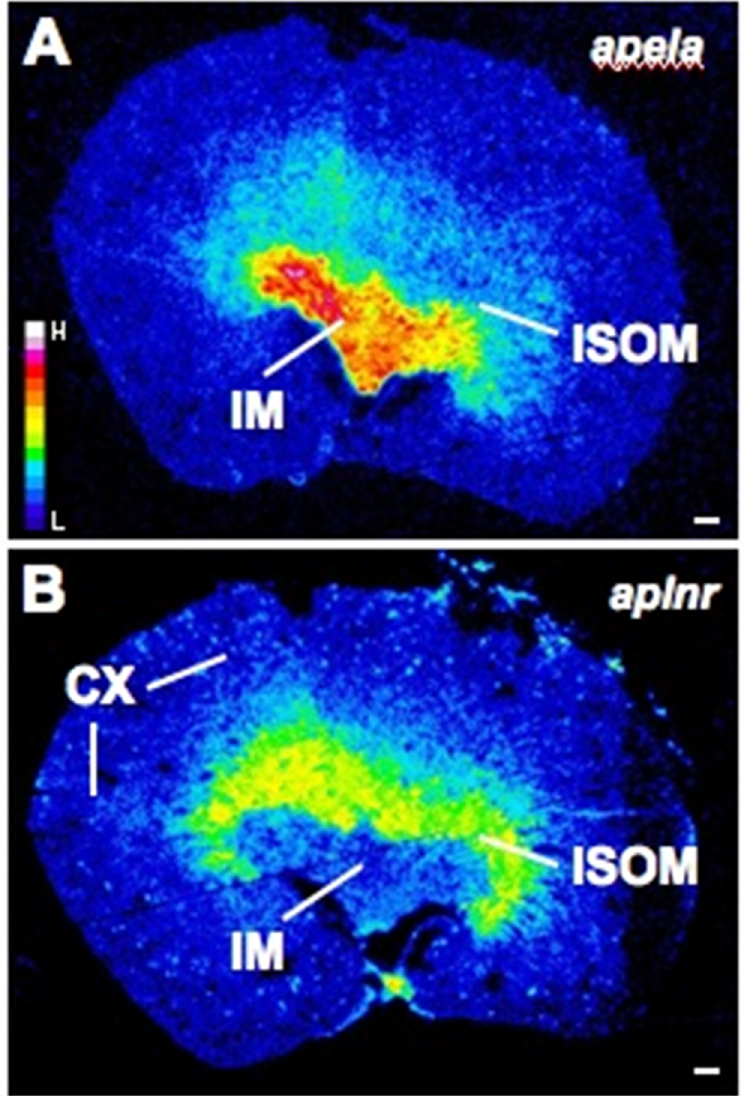
Fig 3. Representative autoradiographic film images demonstrating apela (A) and aplnr (B) expression in serial sections of a kidney from an adult male Wistar rat. Apela is highly expressed in the inner medulla (IM) whereas aplnr labellingis primarily in the inner stripe of the outer medulla(ISOM). In contrast to the apela labelling,the aplnr probesalso label a subpopulation of glomeruli(patchy ‘dots’) in the cortex (CX). The film images were exposed to film for 3 months, developed, scanned,exportedto Image J and pseudocoloured. In these images yellow-reddesignates high expressionwhereasblue-black representsnegligibleor no labelling (see pseudocolour scale bar in ( A )). The images are representative of results obtainedfrom the kidneys of 8 rats. Scale bar = 500 μ